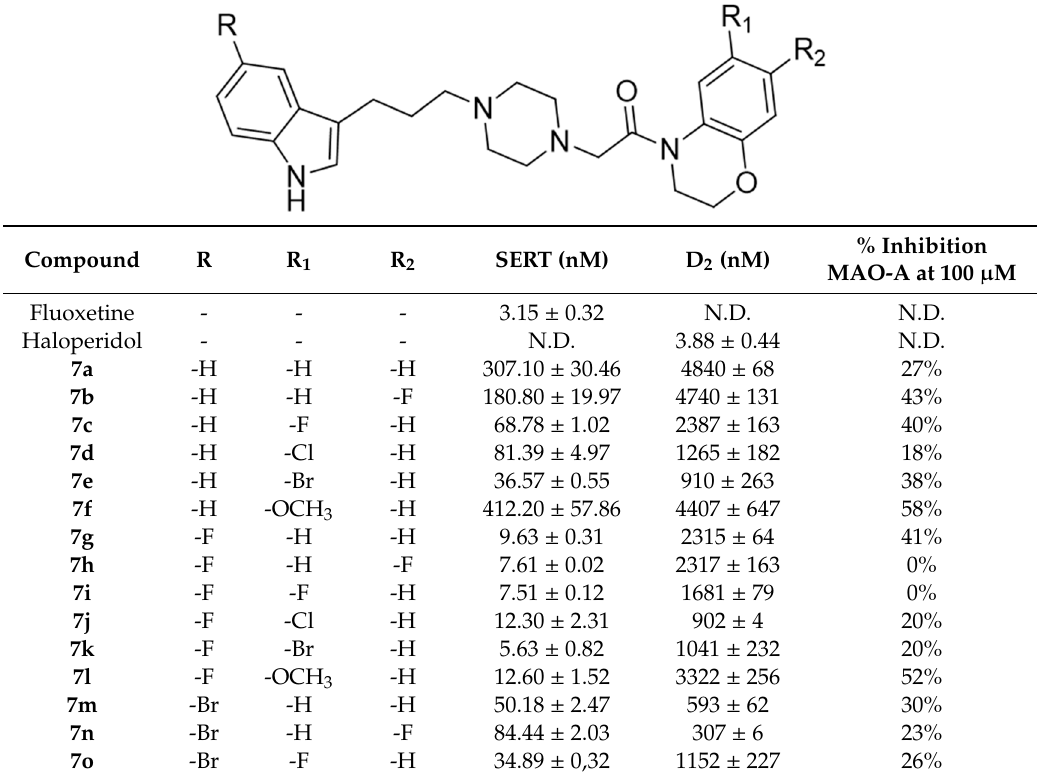
Data represent the mean ± SEM of three experiments, each with triplicate samples. All K i values are in nM. N.D. not